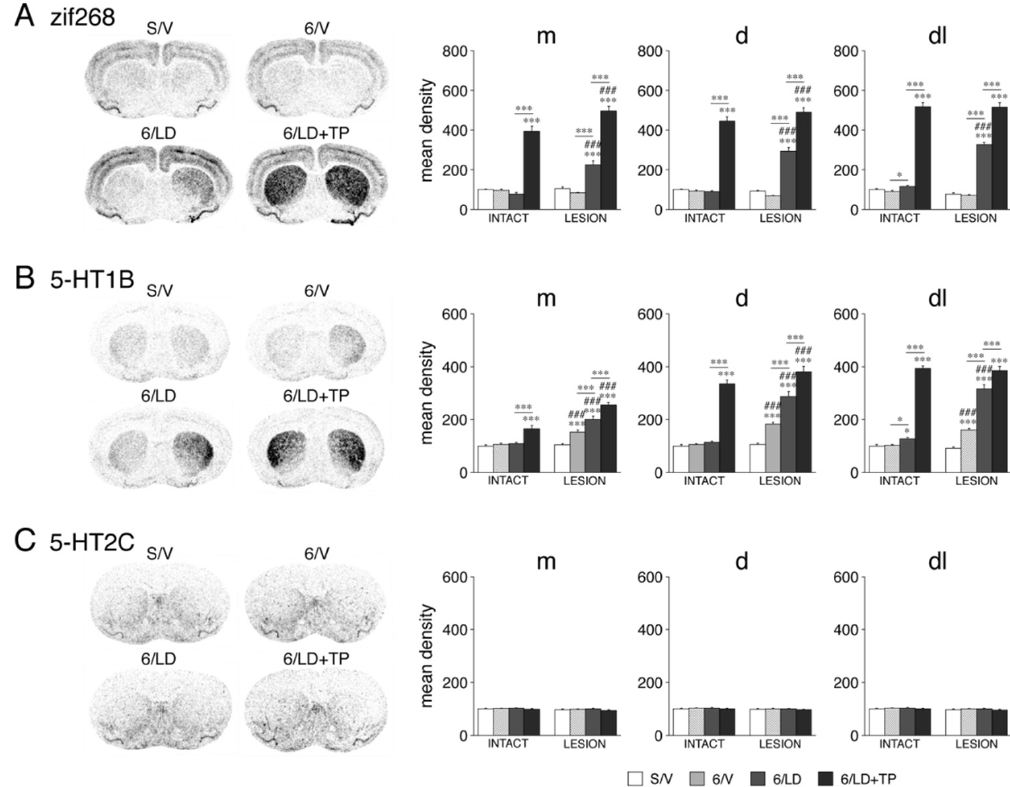
Figure 3. Changes in expression of the immediate-early gene zif268 ( A ) and the serotonin receptor subtypes 5-HT1B ( B ) and 5-HT2C ( C ) in the striatum after dopamine depletion and repeated treatment with L-DOPA and the PDE10A inhibitor TP-10 in adults. Illustrations of film autoradiograms (left) show the expression of zif268, 5-HT1B and 5-HT2C in sections from the middle striatum in sham controls (S/V), after a 6-OHDA lesion (right hemisphere) (6/V), after dopamine depletion followed by repeated L-DOPA treatment (6/LD) or after dopamine depletion followed by repeated L-DOPA plus TP-10 treatment (6/LD + TP). Changes in expression (mean density values, mean ± SEM) (right) for these genes in rats of the S/V, 6/V, 6/LD or 6/LD + TP groups are given for the medial (m), dorsal (d) and dorsolateral (dl) sectors on the sides ipsilateral (LESION) and contralateral (INTACT) to the lesion, on the middle striatal level. The values are normalized relative to values in sham controls (S/V, intact side). Note that zif268 and 5-HT1B, both examples of synaptic activity-regulated genes, showed pronounced changes in expression in response to these experimental treatments, while 5-HT2C was unaffected. * p < 0.05, *** p < 0.001 vs. S/V or as indicated; ### p < 0.001 vs. same group on intact side. After repeated TP-10 + L-DOPA treatment (6/LD + TP), the rats showed a greatly enhanced expression of 5-HT1B in the striatum on both sides (Figure 3B). On the dopamine- depleted side, the expression was increased ( p < 0.05, 6/LD + TP vs. S/V) in all 23